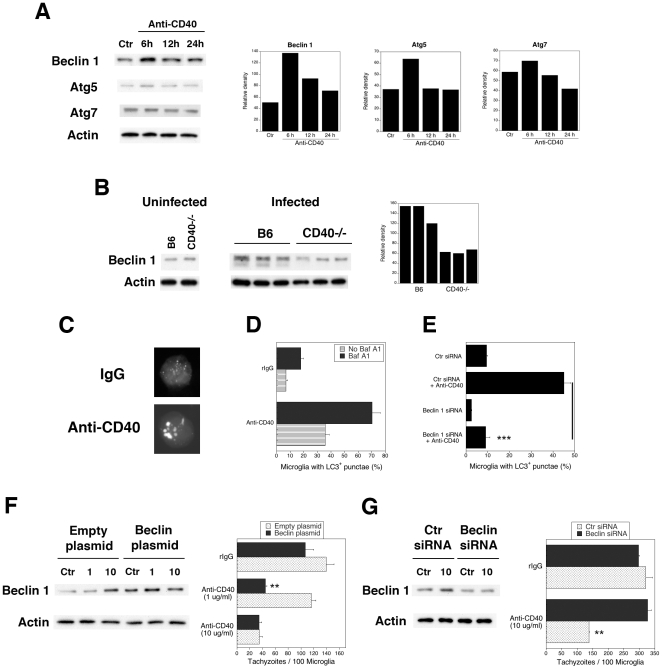
CD40 upregulates autophagy protein expression and leads to increased autophagy.
A, Primary brain microglia from B6 mice were incubated with anti-CD40 mAb or control mAb. Beclin 1, Atg5 and Atg7 protein expression were normalized against actin. B, Beclin 1 and actin protein expression in purified brain microglia from uninfected B6 and CD40−/− mice or purified brain microglia/macrophages from B6 or CD40−/− mice at 4 weeks post-infection. Each lane represents a pool of 2 mice. C, D, BV-2 cells transfected with LC3-EGFP were incubated with anti-CD40 mAb or control mAb in the presence or absence of bafilomycin A1 (BafA1). E, BV-2 cells were transfected with control or Beclin 1 siRNA. After 2 days, cells were transfected with LC3-EGFP followed by incubation with anti-CD40 or control mAb. F, BV-2 cells were transfected with Beclin 1-encoding or empty plasmids. Expression of Beclin 1 and actin were examined by immunoblot. Cells were incubated with anti-CD40 mAb (1 or 10 µg/ml) or control mAb followed by infection with tachyzoites of RH T. gondii. G, BV-2 cells transfected with a suboptimal concentration of Beclin 1 siRNA or control were incubated with anti-CD40 mAb (10 µg/ml) or control mAb followed by RH T. gondii infection. Results are representative of 3 to 4 independent experiments. **p≤0.01; ***p≤0.001.